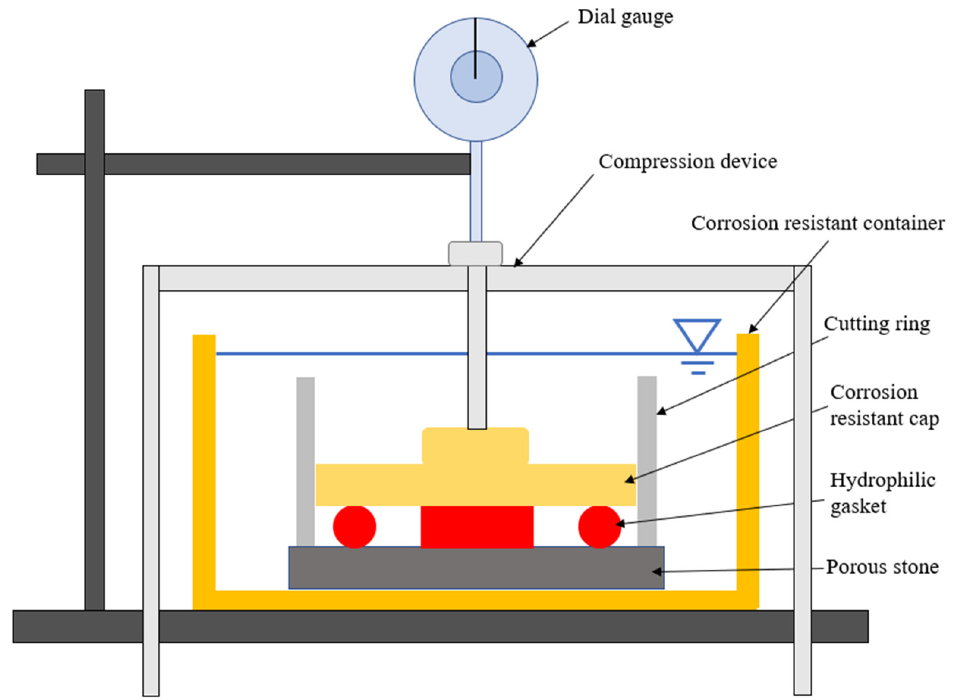
Figure 2. The schematic of radial swelling test devices modified from a single lever consolidation